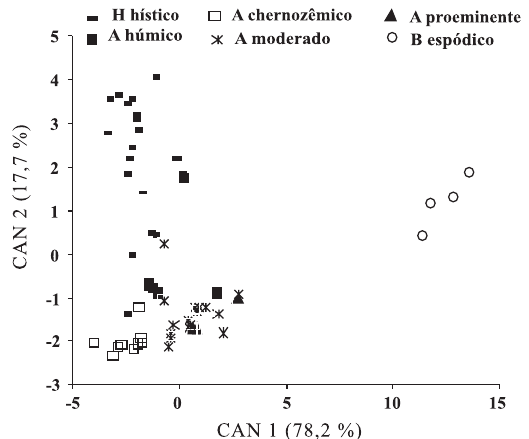
estudadas.Figura 1. Dispersão dos escores dos horizontes diagnósticos nos dois primeiros eixos canônicos.